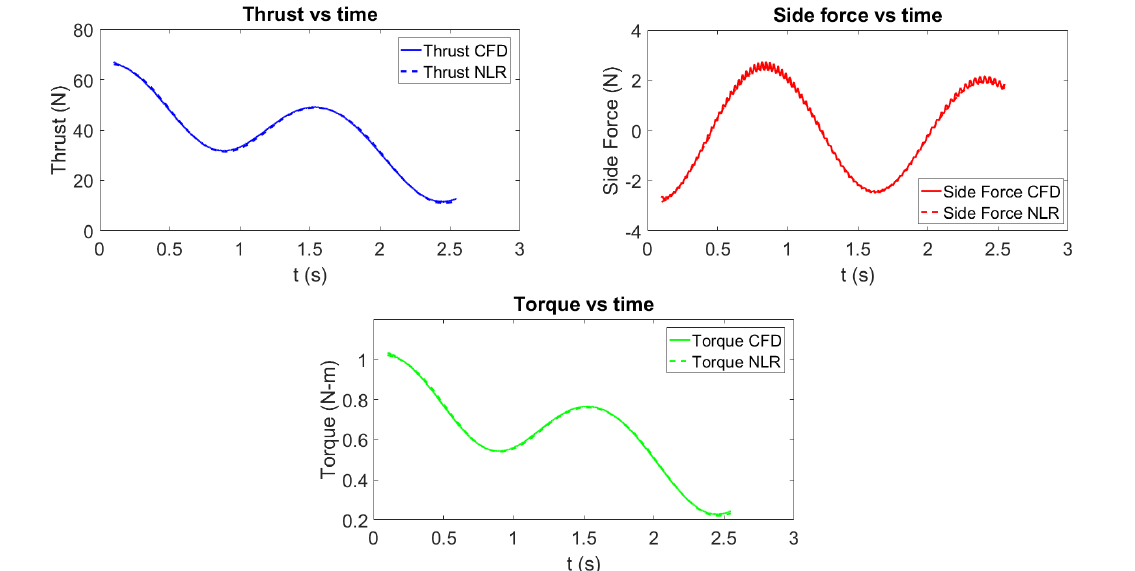
Figure 10. Open water thrust, side force, and torque for the test data set as a function of time using nonlinear regression.